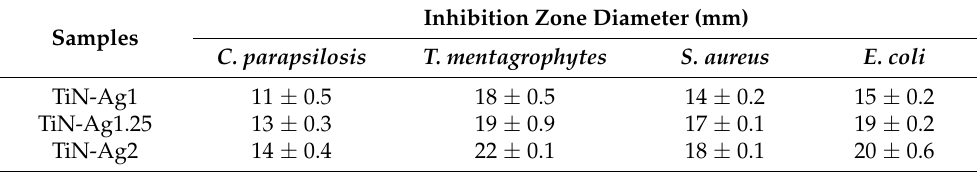
Table 3. Zone of inhibition